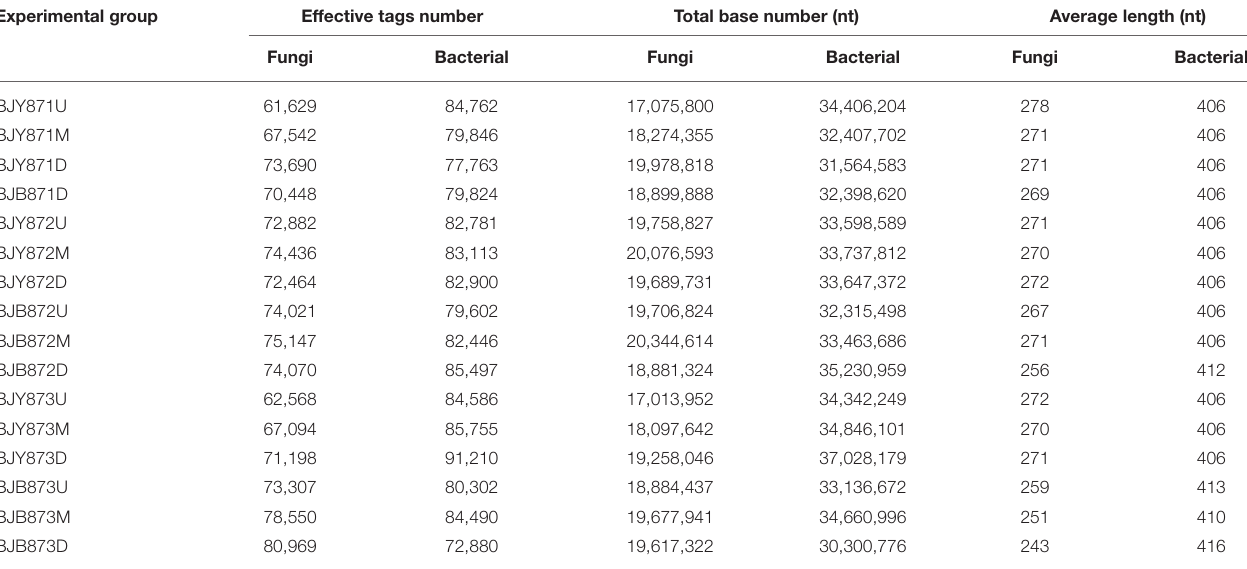
TABLE 1 | Data quality control of sequencing